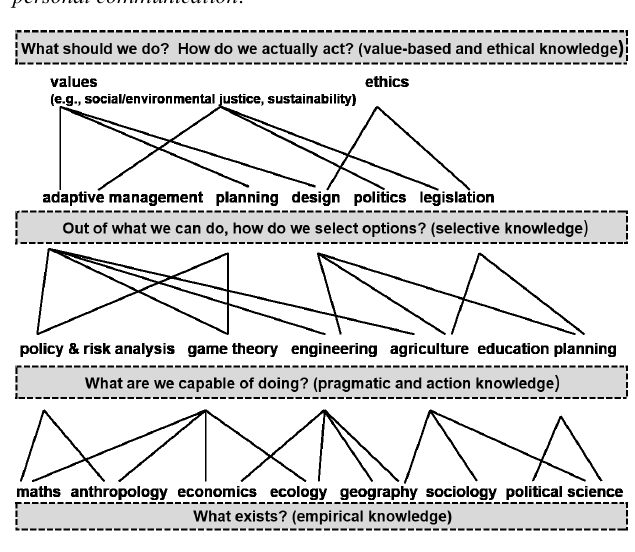
Fig. 2 . A layered concept of transdisciplinarity adapted from Max-Neef (2005), Palmer and Munnik (2018); C. Mitchell, personal communication